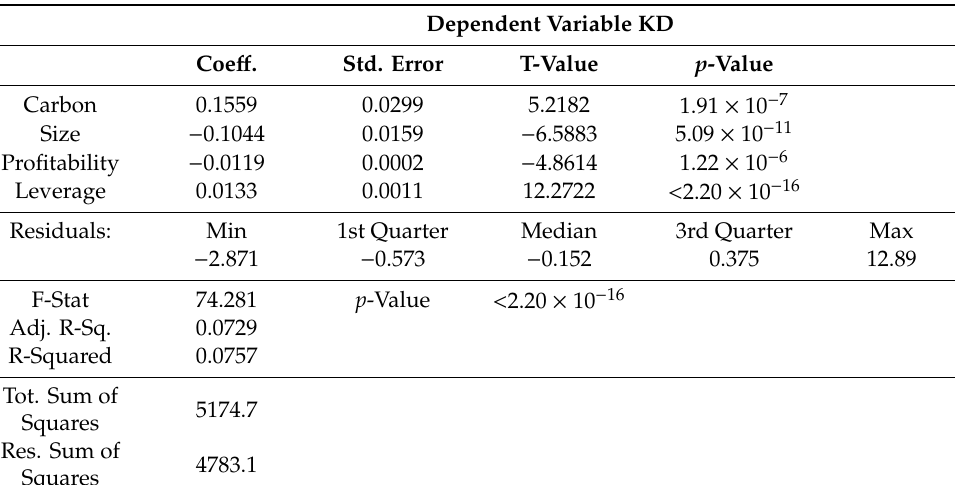
Table 2. Panel regression